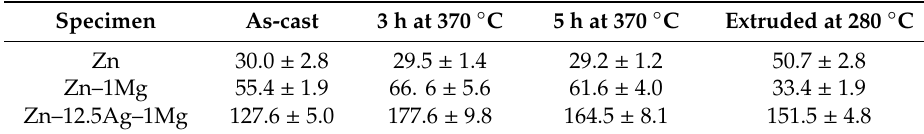
Table 3. Microhardness (HV) measurements of the alloys for di ff erent conditions. Figure 9. ( a ) Microhardness measurements (HV) of the investigated alloys; ( b ) tensile properties of Specimen As-cast 3 h at 370 ◦ C the extruded alloys at room temperature; ( c , d ) SEM fractographies of the extruded alloys (Zn-1Mg and Zn-12.5Ag-1Mg, respectively).